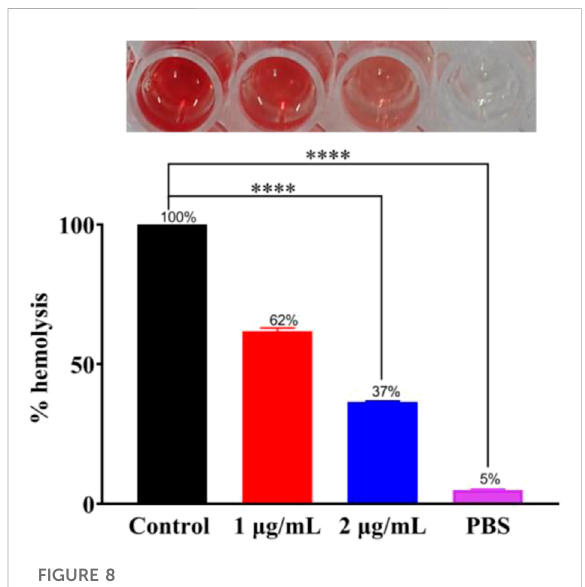
FIGURE 8 Experimental results of Ru-3 inhibitory toxin. Effect